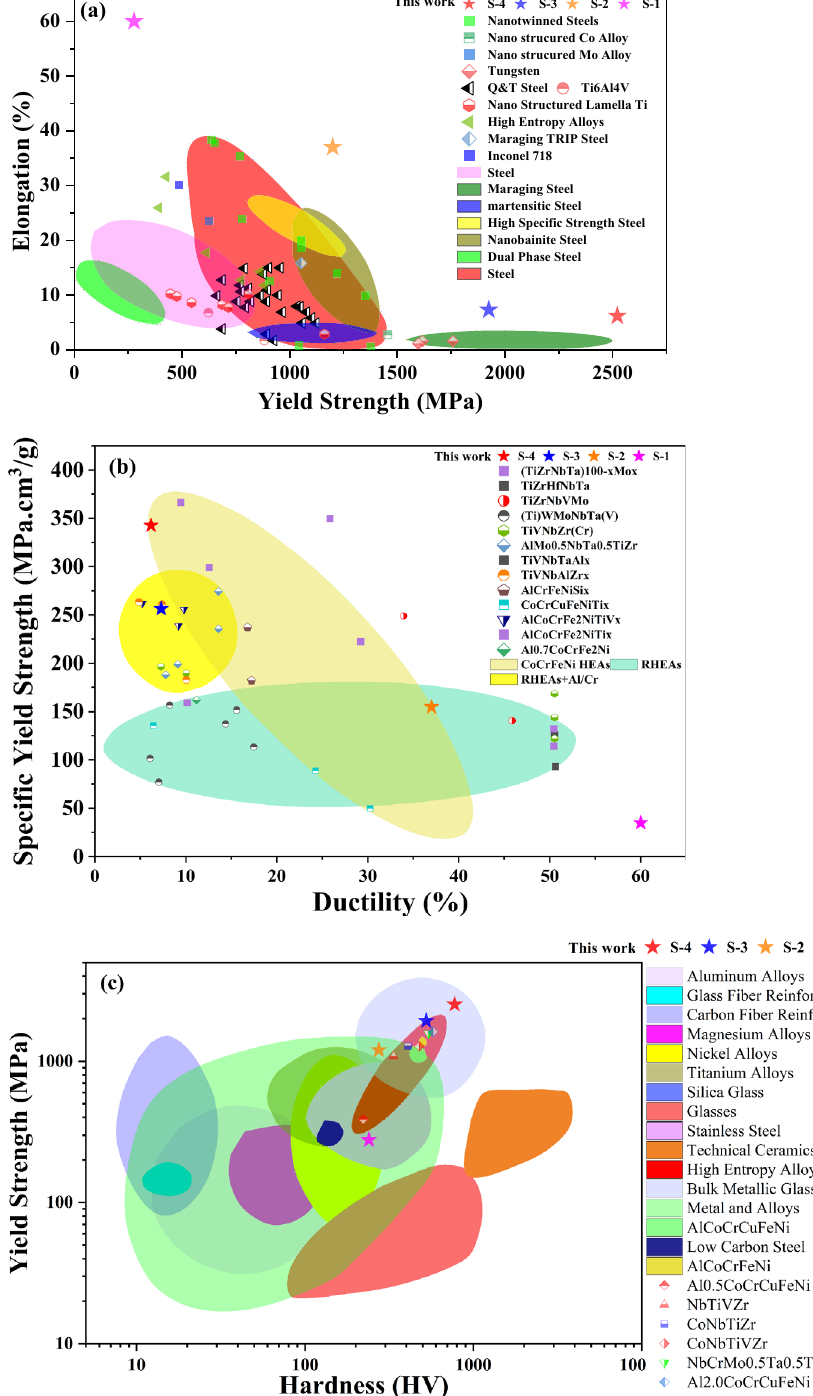
Figure 11. Comparison of results of the present study with different engineering materials and HEAs: ( a ) Elongation versus yield strength 62 , ( b ) specific yield strength versus ductility 63 , and ( c ) yield strength versus hardness 65